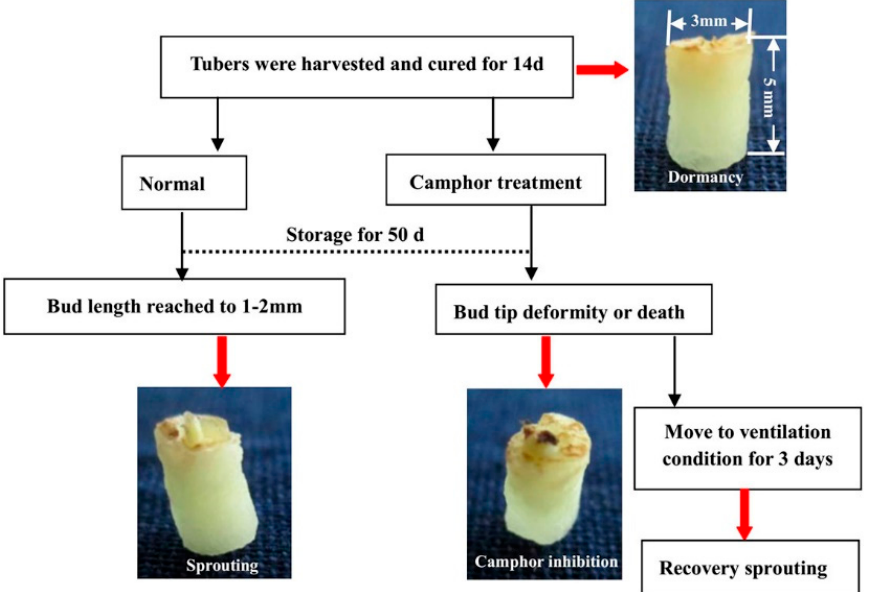
Figure 10. Treatment schematics for the experimental samples are listed. Red arrows represent the four types of samples.